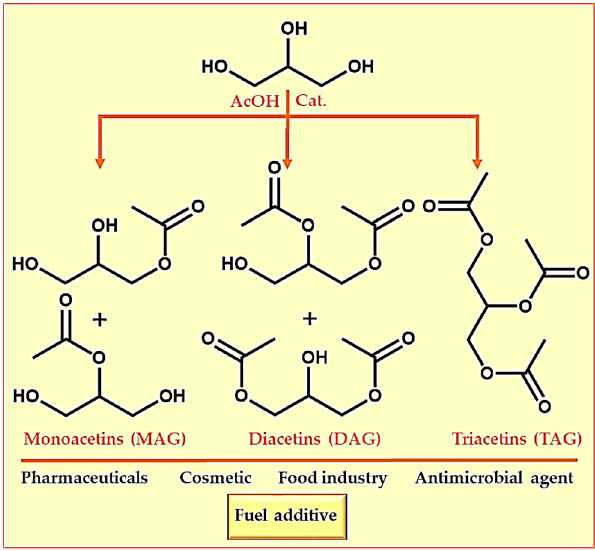
Figure 3. Industrial production of acetins and applications.